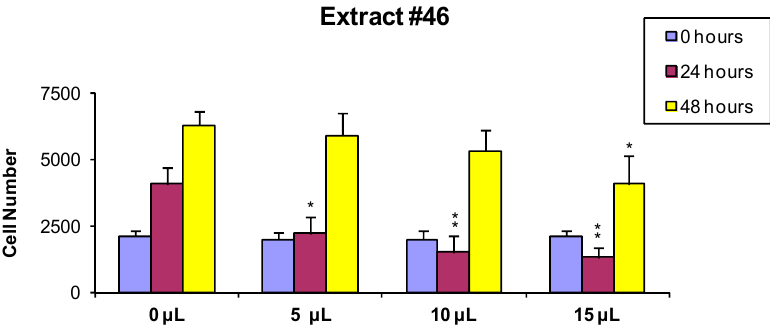
Figure 2. MCF-7 cells were treated for 24 h with 0 (controls), 5, 10 and 15 µL/mL of the extract #46, washed and counted. Two thousand cells from each incubation condition were seeded in a fresh medium-extract-free and counted again 24 and 48 h later ( p values: * < 0.1; ** < 0.01).